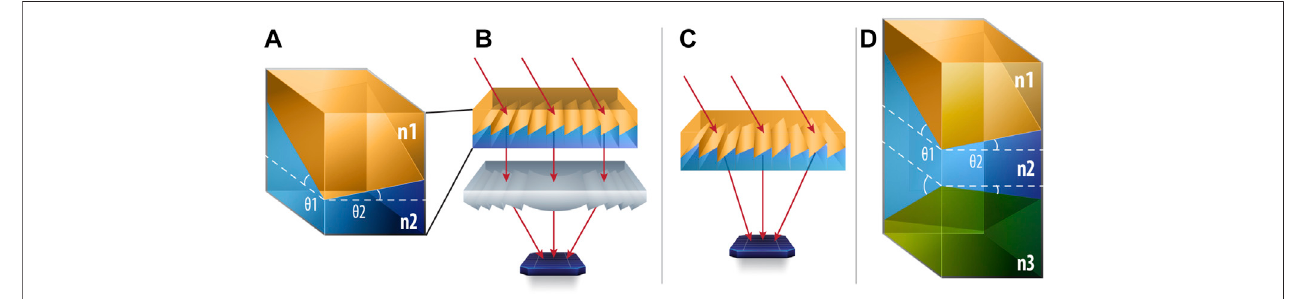
FIGURE 1 | Evolution of electrowetting-based beam-steering tracker concepts, from (A) an array of simple EW prisms with a single water-oil interface, modifying the propagation angle of sunlight to (B) maintain uniform illumination of a Fresnel lens, to (C) independent control of the voltage and consequent wetting angle in each prism to achieve simultaneous beam steering & concentration without the need ofa separate concentrating lens (Khan et al., 2020); and (D) realization of larger steering angles by use of a compound prism with two interfaces between three different immiscible liquids (Chen et al., 2021).